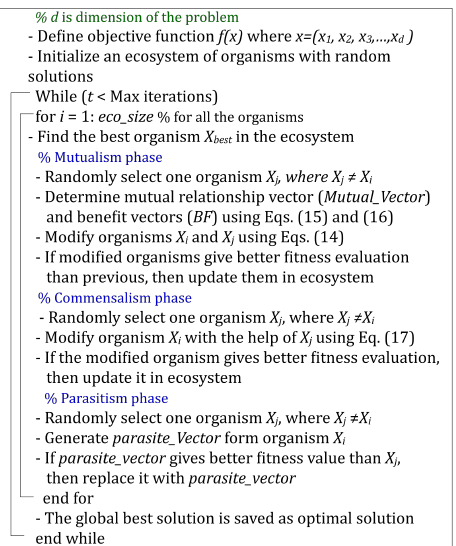
Figure 14. Symbiotic organism search (SOS) algorithm in pseudocode